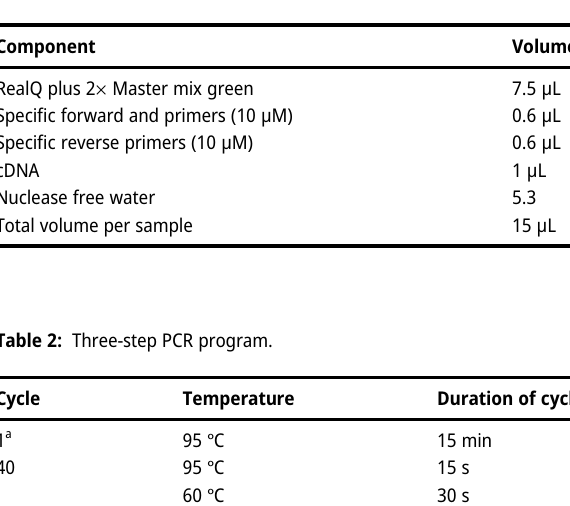
Table  : Preparation of the reaction mix for qPCR.